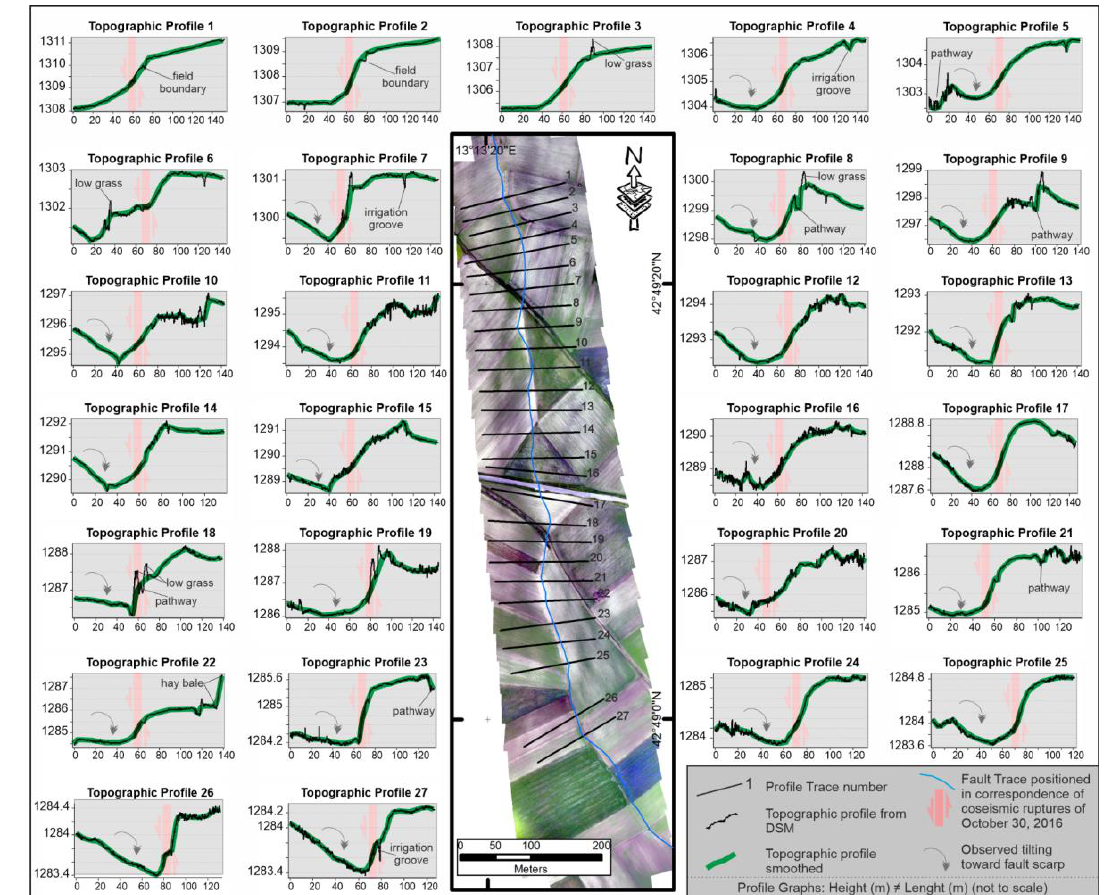
Figure 10. Topographic profiles generated using “3D analyst” in the ArcGis platform (Orthomosaic Photo and DSM have a resolution of 3 cm per